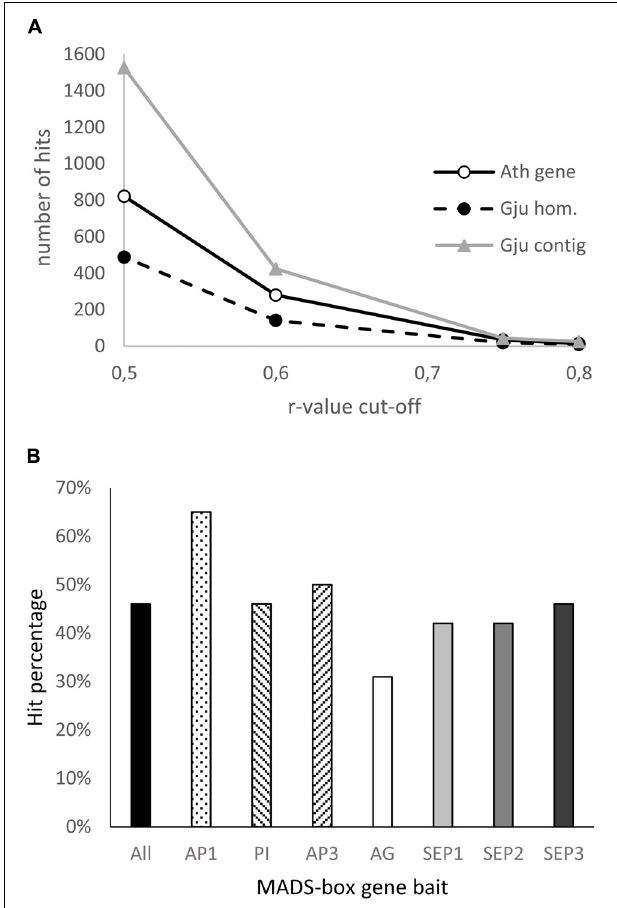
FIGURE 7 | Analysis of the Grevillea juniperina homologs of genes co-expressed with the ABCE model MADS-box genes in Arabidopsis thaliana . (A) Number of A. thaliana genes (At gene) of the GRN and their homologous sequences in G. juniperina (Gju hom) plotted relative to the Pearson correlation coefficient ( r -value) cut-off. The number of corresponding contigs for each homolog (Gju contig) are also plotted. (B) Percentage of the 25 A. thaliana MADS-box best-correlated genes having at least one homolog in G. juniperina . The list of the 25 best correlated genes was done using each of the seven A. thaliana MADS-box genes as a bait, or a compilation of the best correlated to all the ABCE MADS-box genes (all).